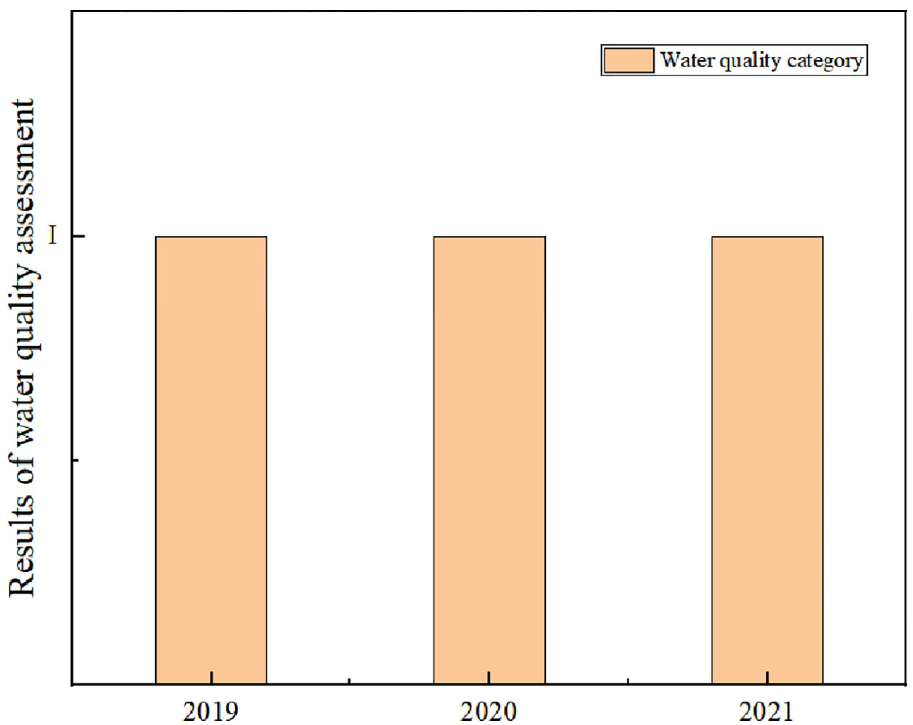
Fig 1. Results of water quality assessment by single factor pollution index method.